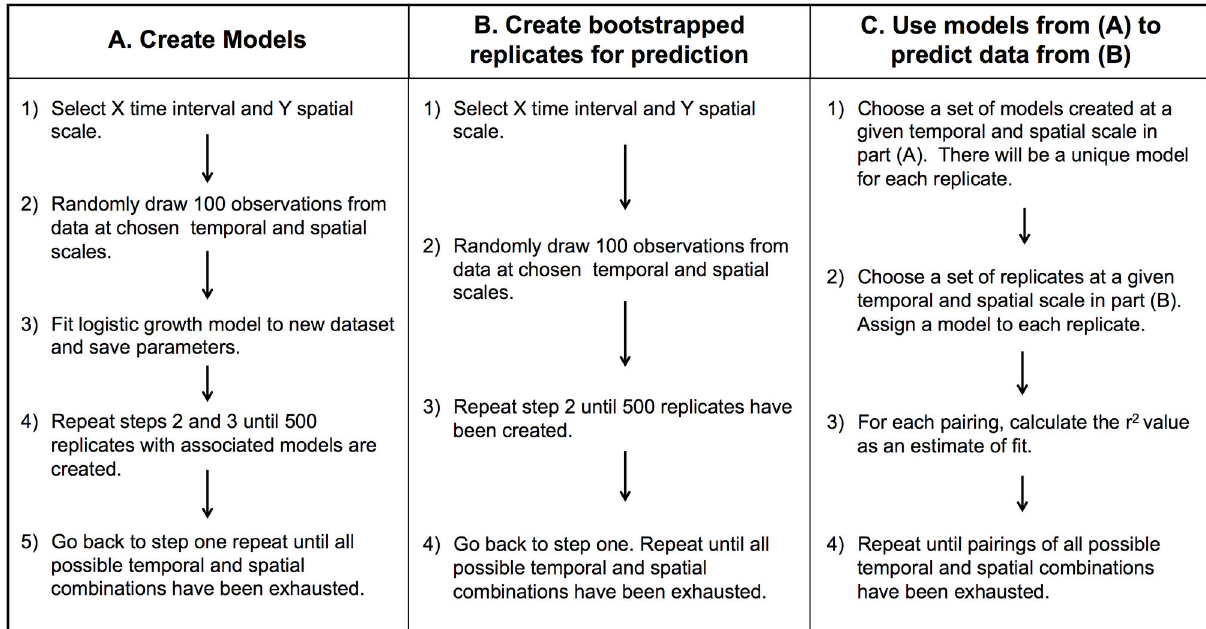
Figure 2. Overview of methods. Flow chart providing an overview of a) model creation, b) creation of datasets for prediction, and c) application of models to datasets for prediction. Note that the details for each data set differs. Details for step (a) can be found under the heading Model Creation and Parameterization in the methods section. Details for steps (b) and (c) are available under the heading Model Application in the methods